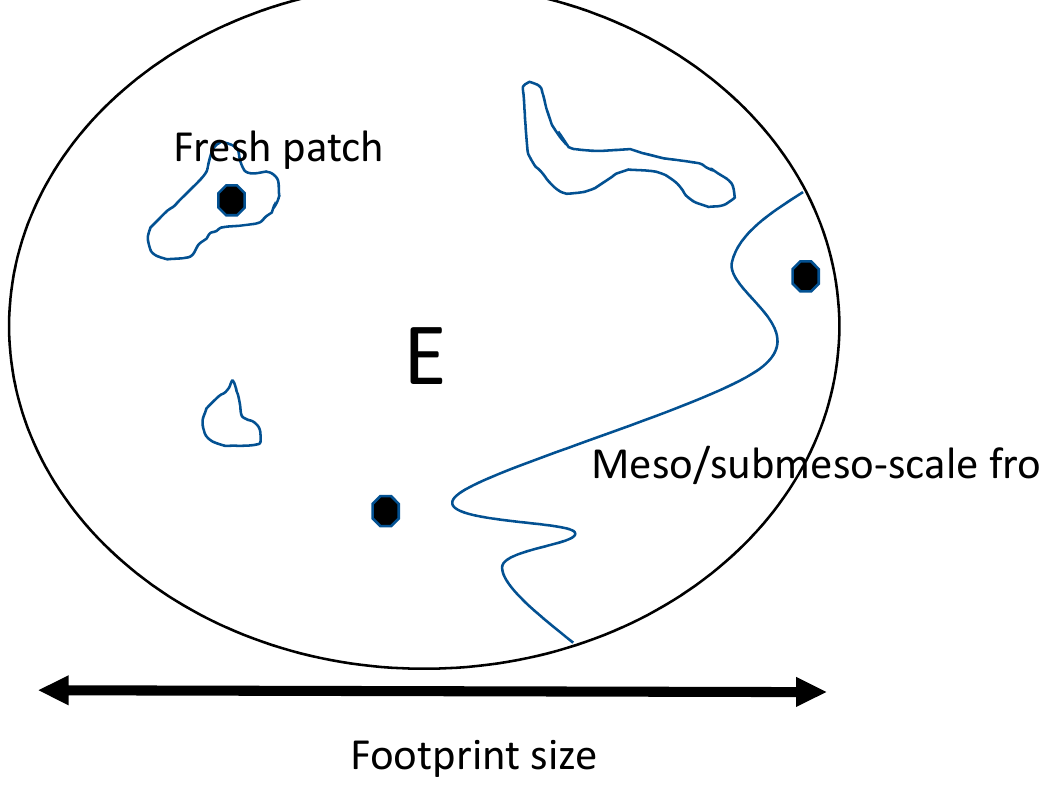
Figure 1. Schematic view of a satellite footprint. The large circle is the satellite footprint. ‘E’ is the point at the center of the footprint where the satellite estimate is made. Dark symbols are potential in situ validation measurements. A mesoscale/submesoscale front snakes through the footprint and a fresh patch, possibly due to recent rainfall, is indicated.